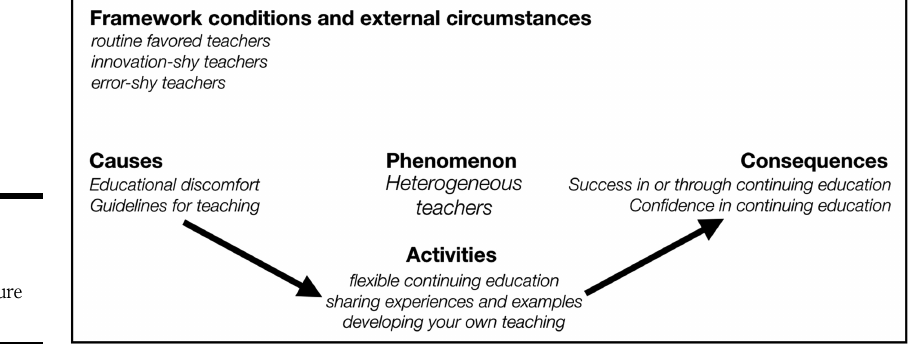
Figure 3. Prototype procedure for axial